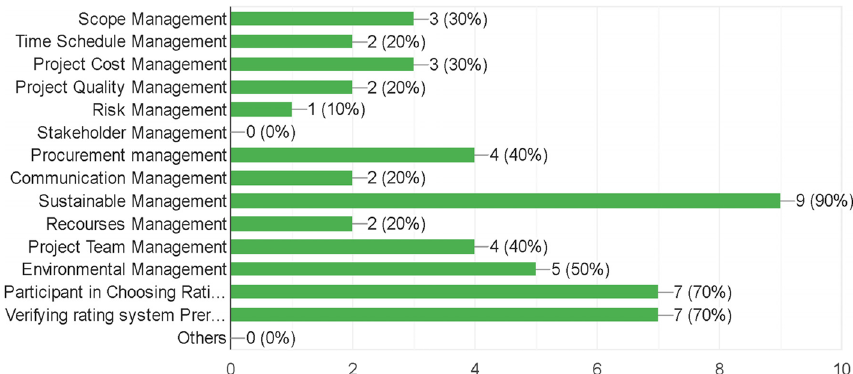
Fig. 3 The area of knowledge in which project managers participate in green building projects. Ref: Researchers